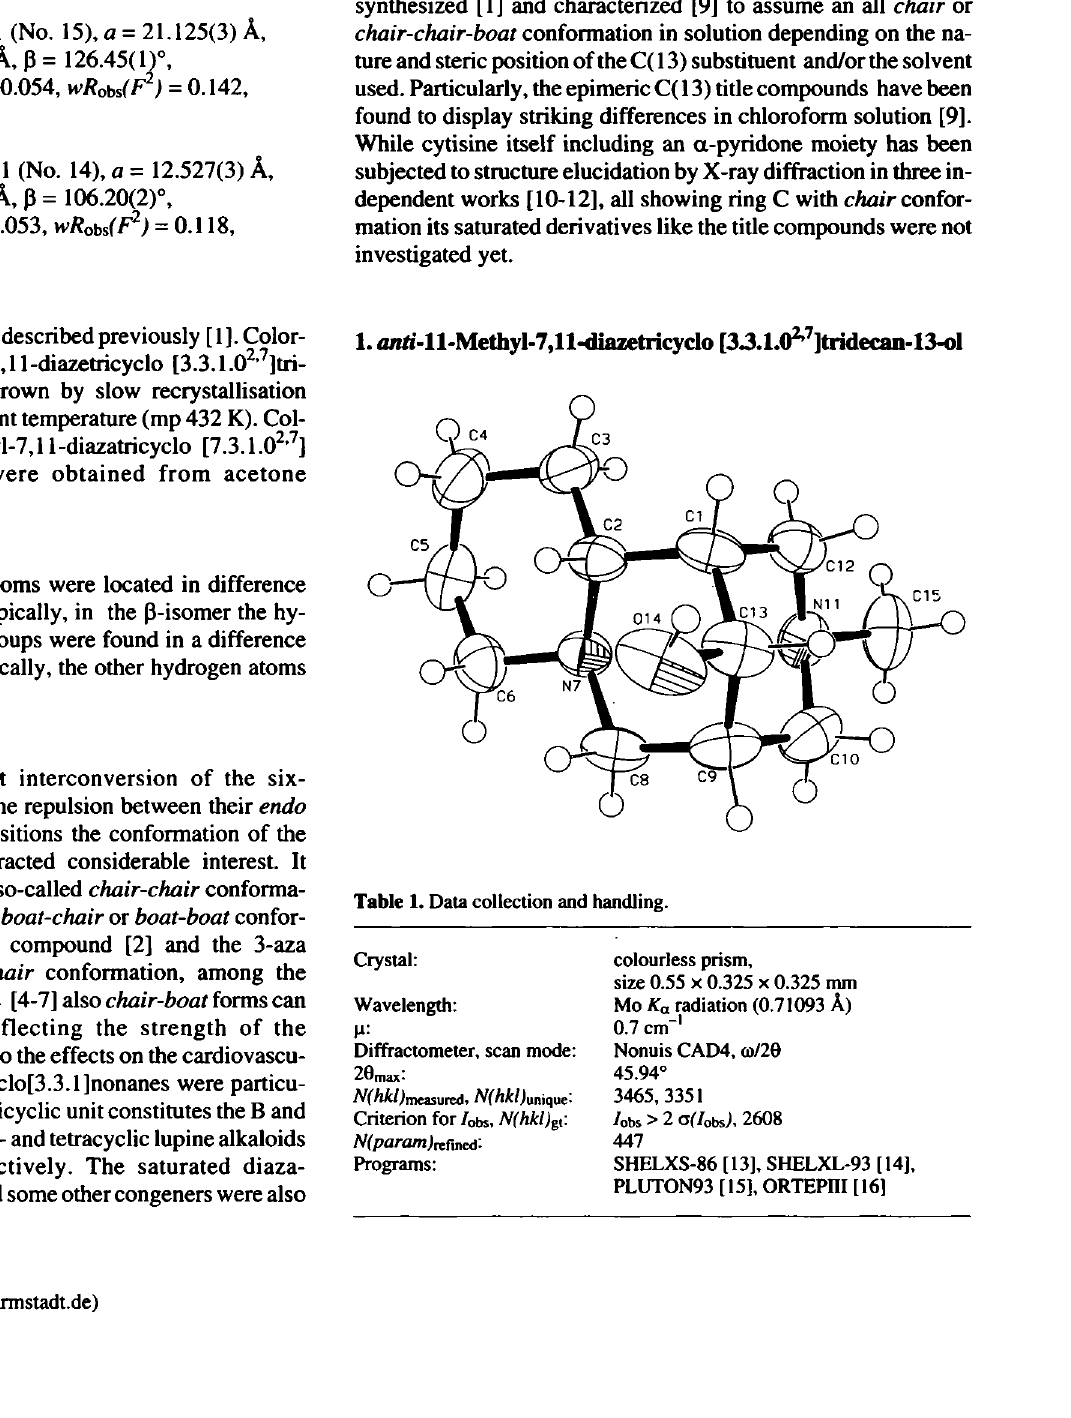
Table 1. Data collection and